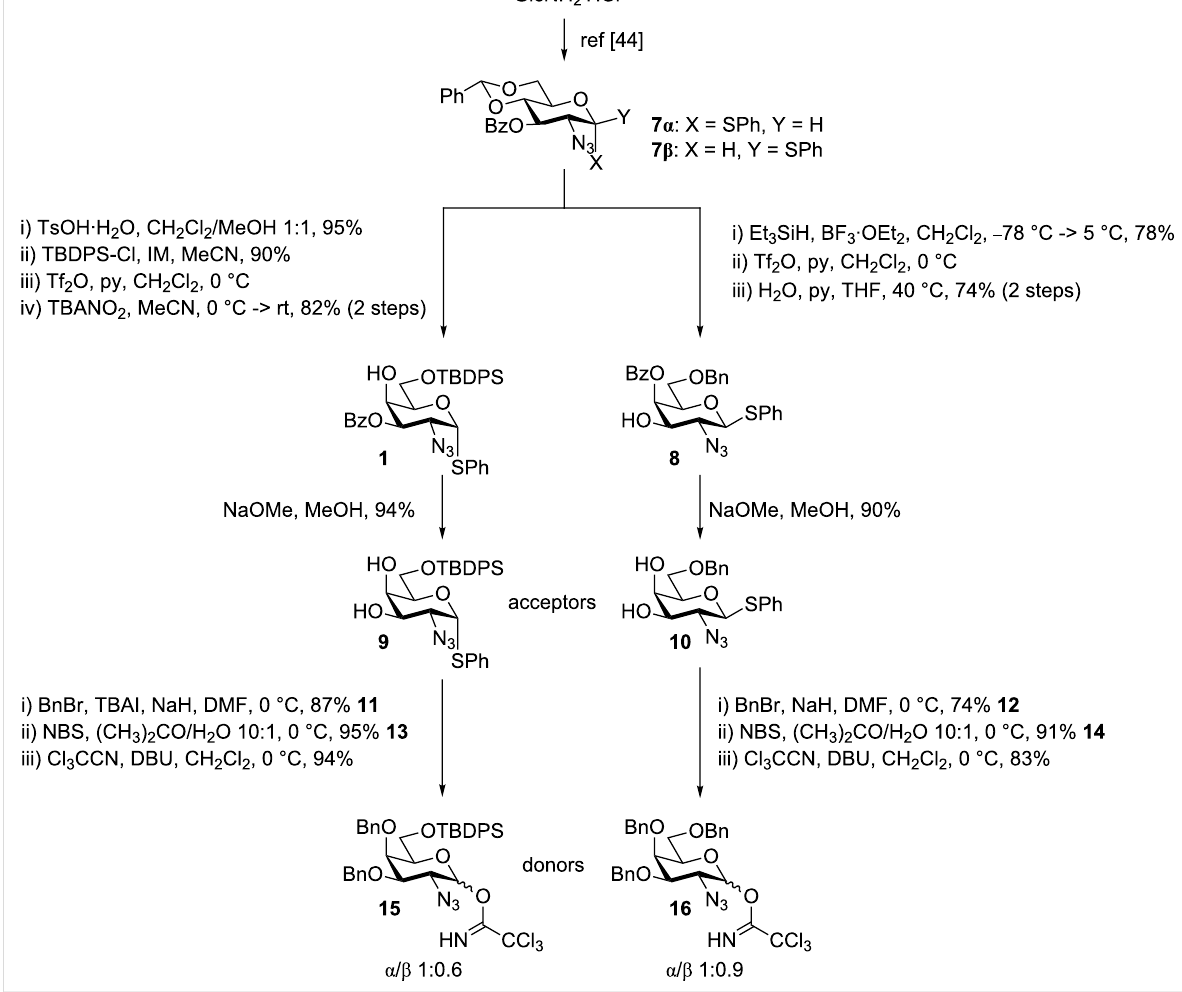
Scheme 2: Simple synthesis of two acceptors and two donors from the same common and readily available building